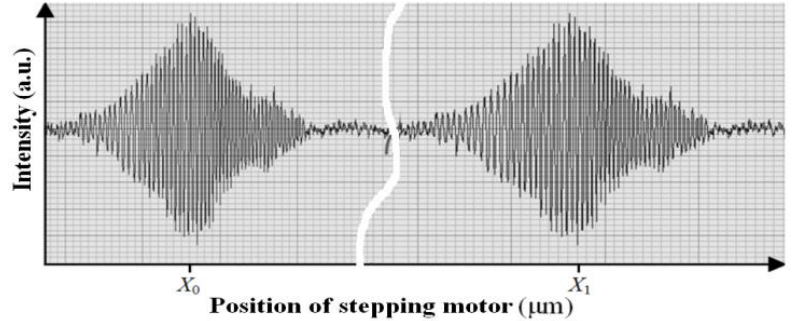
Figure 2. The interference fringes of LCFS and position